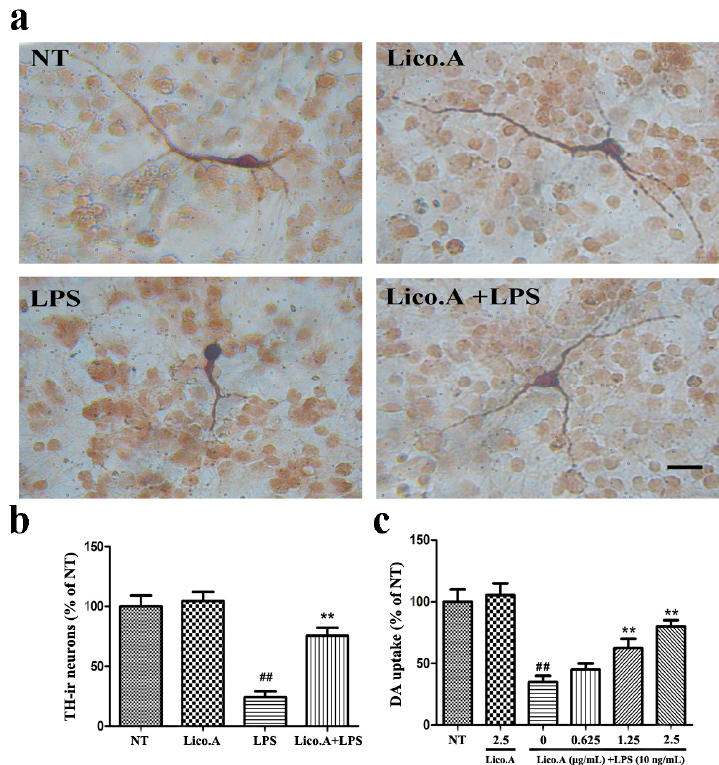
Figure 4. Lico.A prevents LPS-induced degeneration of dopaminergic neurons in cultured mesencephalic neuron-glia. ( a ) The degeneration of dopaminergic neurons was assessed by TH immunostaining. Scale bar, 250 µm; ( b ) The TH-ir neuron was counted; ( c ) The level of [ 3 H]DA uptake was measured. All the experiments were repeated at least three times and similar results were observed. Values are mean ± SE, ( n = 5 samples/group). # p < 0.01, vs. NT group and * p < 0.05, ** p < 0.01 vs. LPS group.